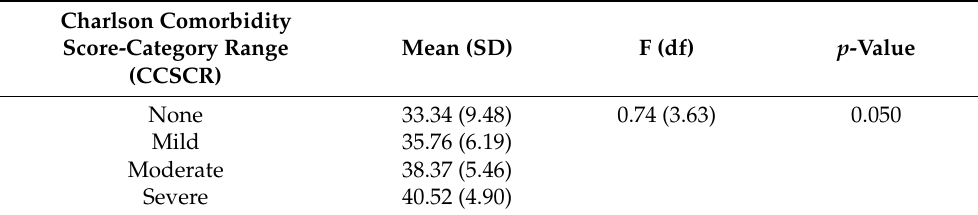
Table 9. Independent t -test to determine the association between tumour grades and medical comorbidity status of patients with colorectal